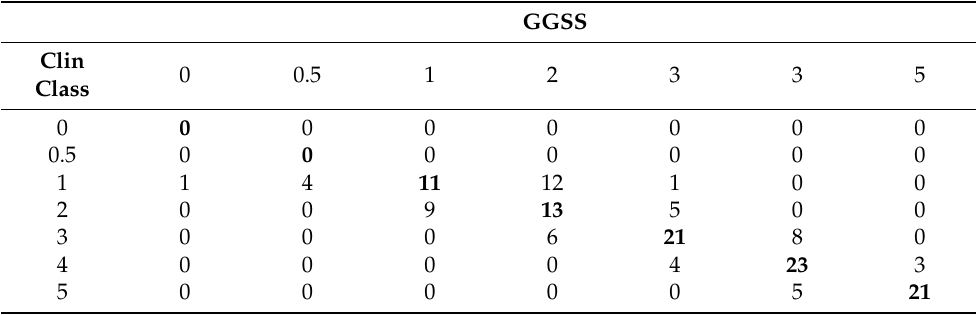
Table 2. Contingency table showing the agreement between the GGSS and the clinical classification. The numbers in bold indicate a perfect correspondence between the two